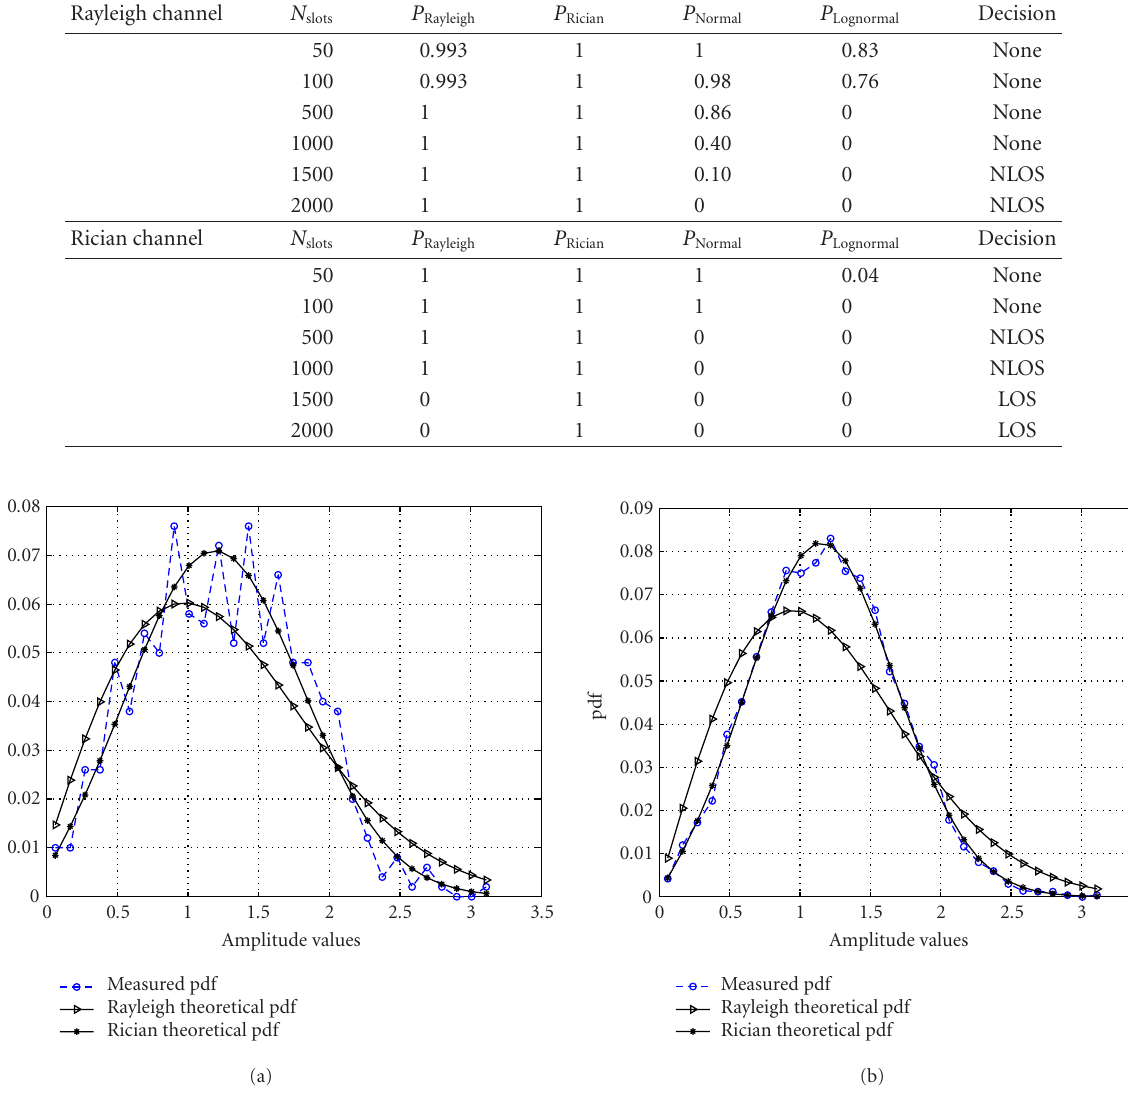
Figure 5: Estimated and theoretical Rayleigh and Rician pdfs for N slots = 500 (plot (a)) and N slots = 1500 (plot (b)). Rician channel profile ( K r = 15 . 5dB), v = 22 .